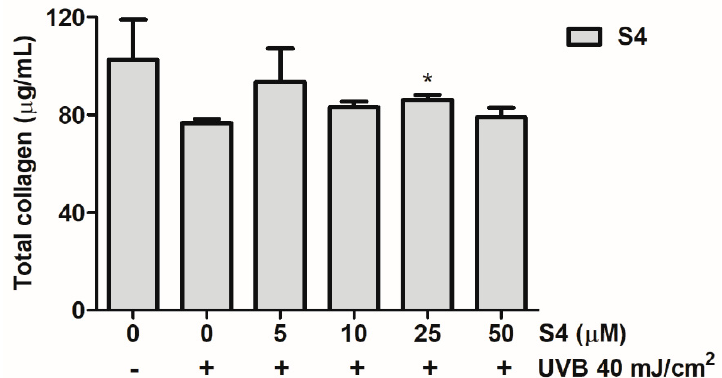
Figure 6. Effect of S4 on total collagen synthesis in human skin fibroblasts. The results were given as mean ± standard deviation (n = 3). Significant difference versus non-treatment group: *, p < 0.05.